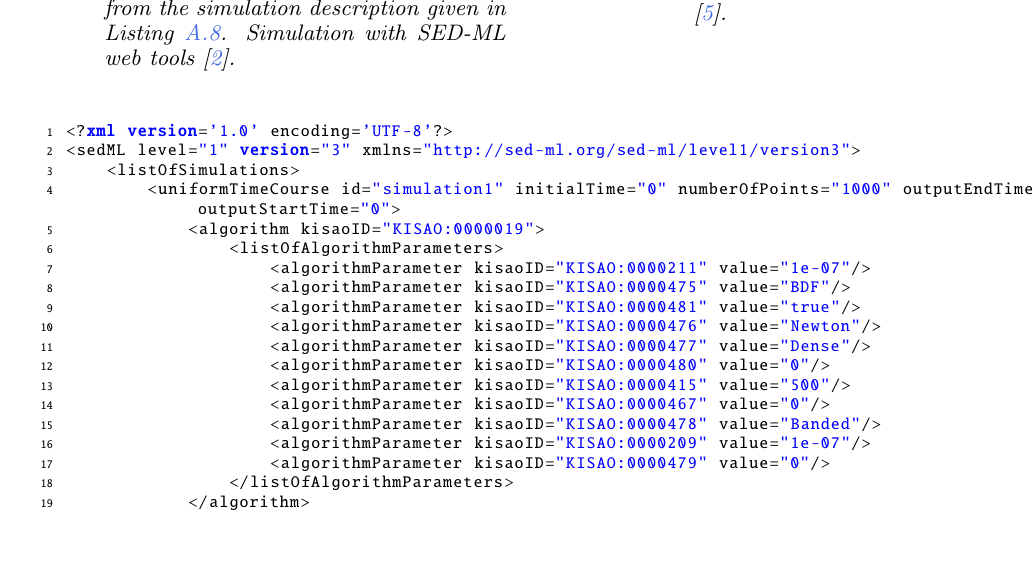
Figure A.14: Simulation with tellurium